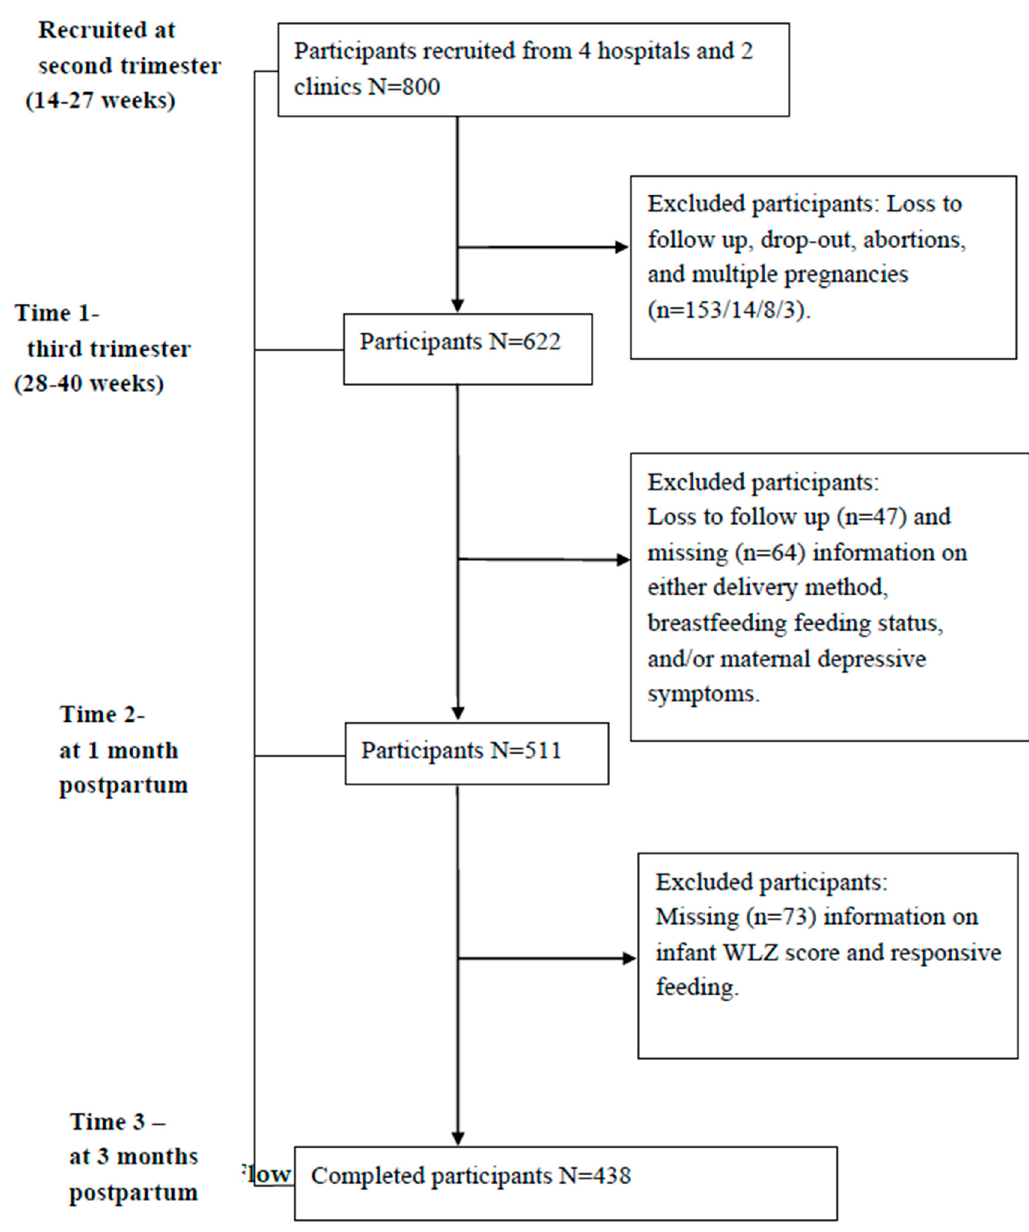
Figure 1. Flow diagram of the sample.